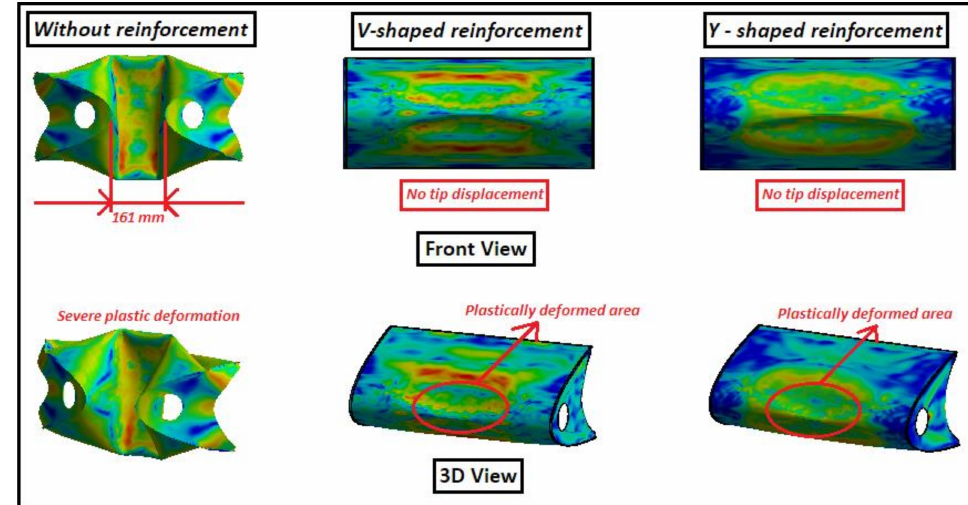
Figure 11. Permanent deformation of the wing leading